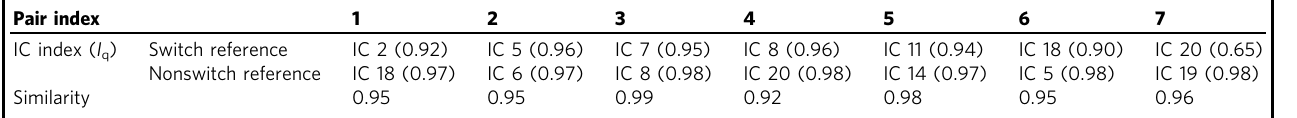
Table 1 Independent component (IC) stability and IC pair similarity in the gate opening condition.